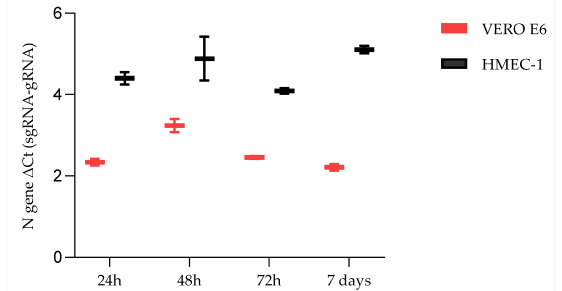
Figure 3. SARS-CoV-2 variant B.1 N1 gene ∆ Ct (sgRNA-gRNA) values. The sgRNA and gRNA cycle threshold values at 24, 48, 72 h and 7 days p.i. were obtained by means of two qRT-PCRs targeting the N1 gene. Plots whiskers indicate down to the minimum and up to the maximum value for each time